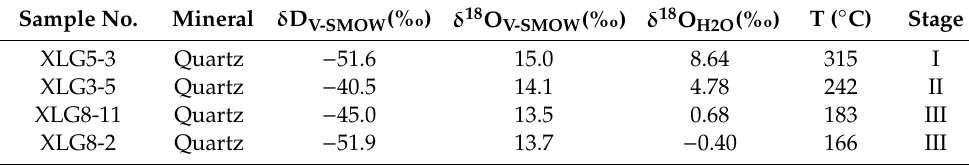
Table 2. The δ D V-SMOW and δ 18 O V-SMOW values of the fluid inclusions in quartz, and calculated values for equilibrium fluids from the Xialiugou deposit.